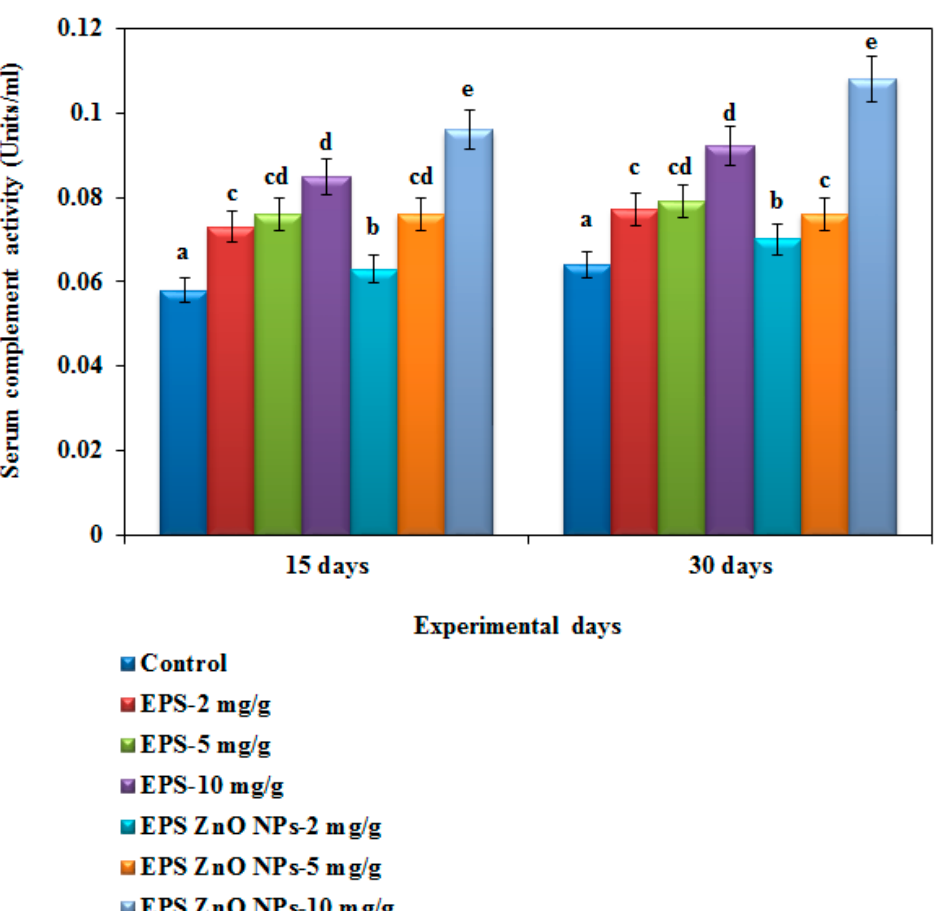
Figure 7. Serum innate immune complement hemolytic activity of O. mossambicus fed with EPS and EPS-ZnO NPs. T-bars indicate three replicates of mean ± SD, and different letters corresponding to the statistical difference between treated